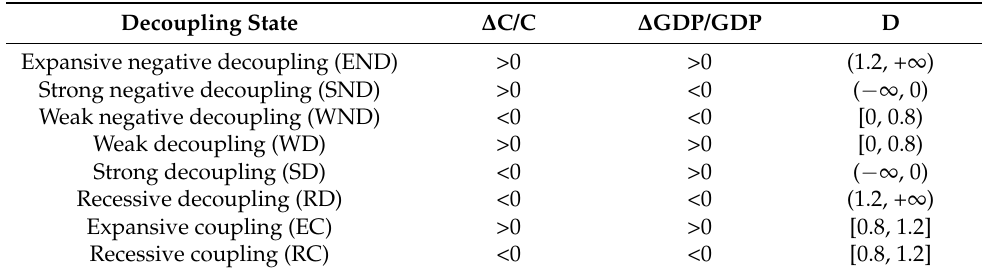
Table 3. Judgment criteria of the Tapio decoupling model.